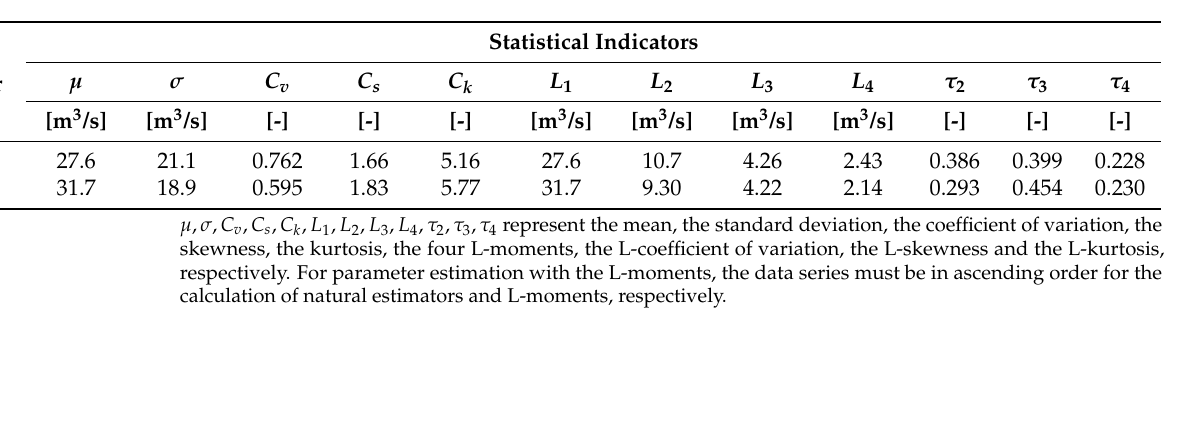
Table 6. The statistical indicators of the data